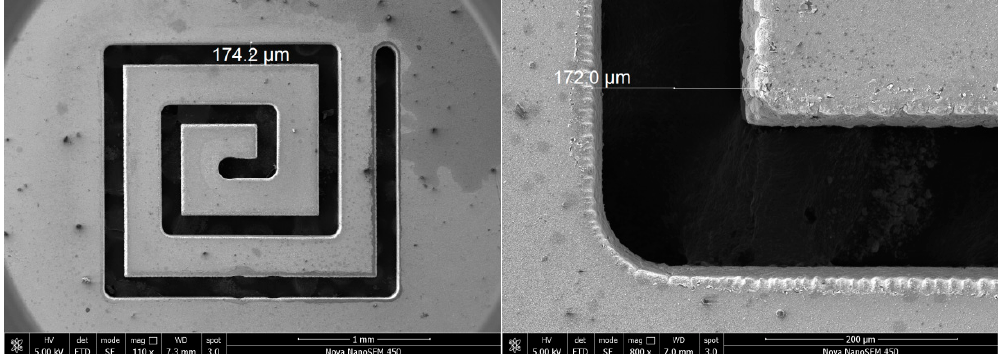
Figure 16. Closed micro structure on 300 μ m thick glass.